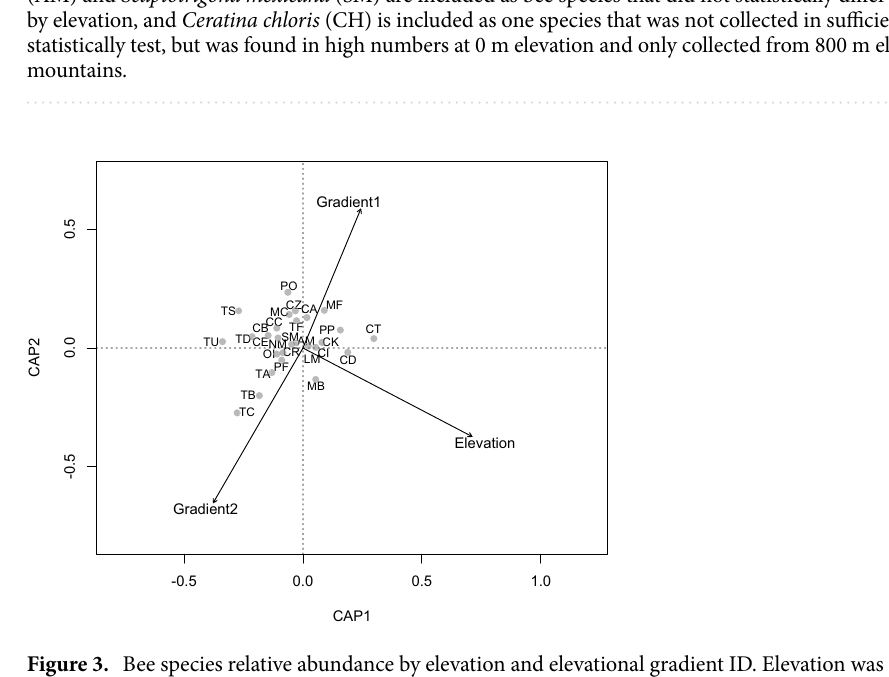
Figure 3. Bee species relative abundance by elevation and elevational gradient ID. Elevation was significant in explaining ~ 23% of the variation in bee community